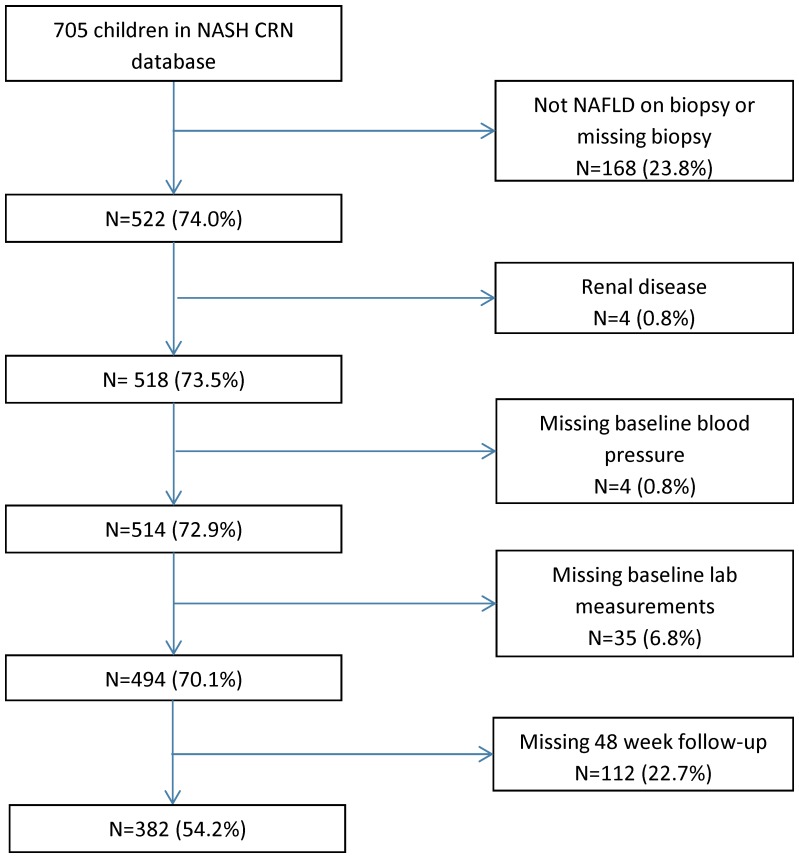
Flowchart shows the application of study inclusion and exclusion criteria.